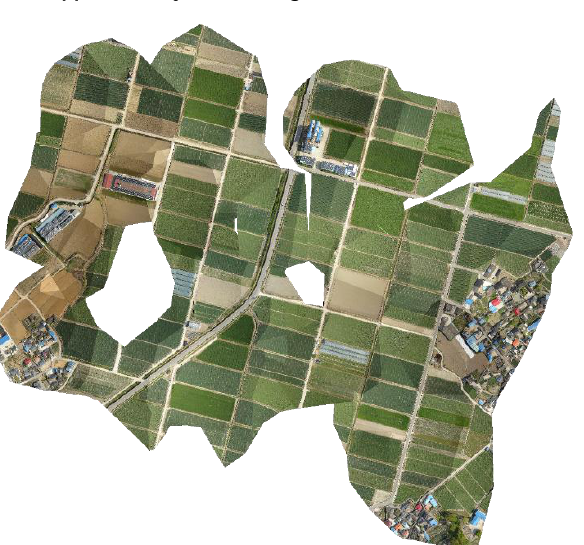
Figure 9. Example of primary mosaicking